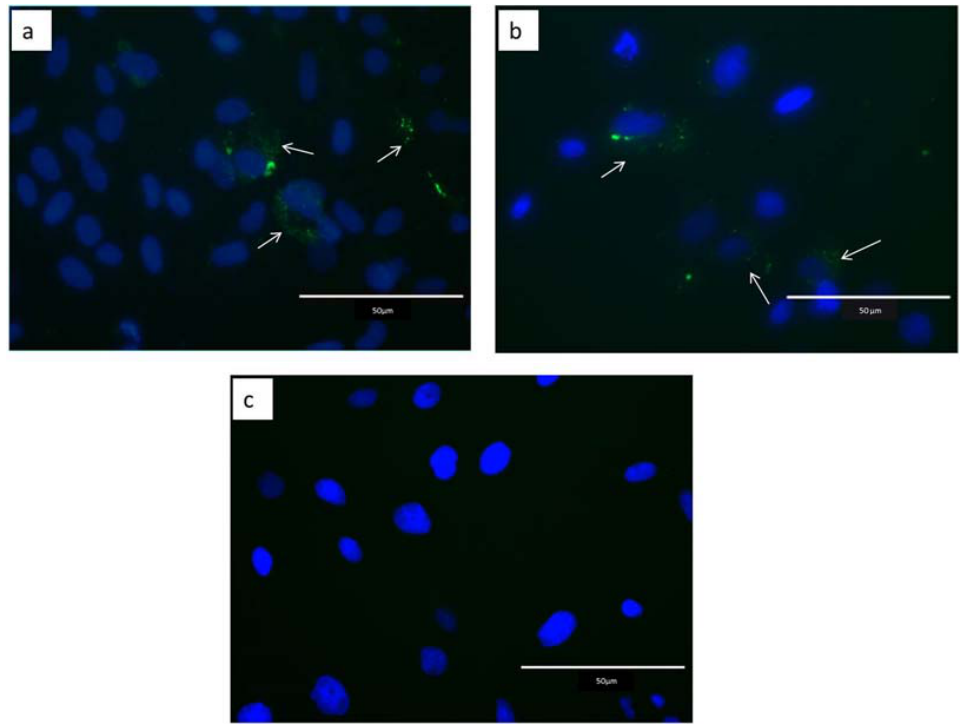
Figure 3. Fluorescence images of epithelial endometrial cells incubated with EVs secreted during the blastulation of bovine embryos produced in vivo (EVs-IVV) or in vitro (EVs-IVP). ( a ) EVs released from embryos produced in vitro. ( b ) EVs released from embryos produced in vivo. ( c ) Negative control (PBS/PHK67). Cells were incubated with stained vesicles for 24 h. Arrows highlight the green dots in the cell cytoplasm, indicating internalized EVs stained with PHK67 dye.